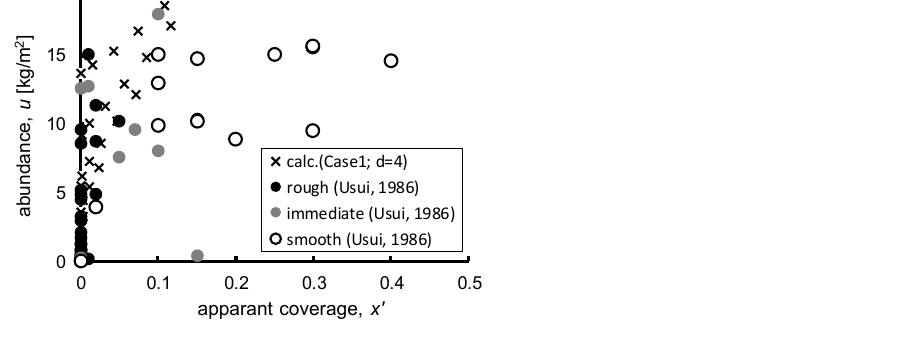
Figure 15. Relation between x ′ and u . Crosses indicate nodule abundances calculated under condi- tions with Case1 and d = 4. Circles indicates ground-truth data of nodule abundances in Central Pacific Ocean [27]. Different colors of the circles mean different roughness of surface for nodules collected at each location.